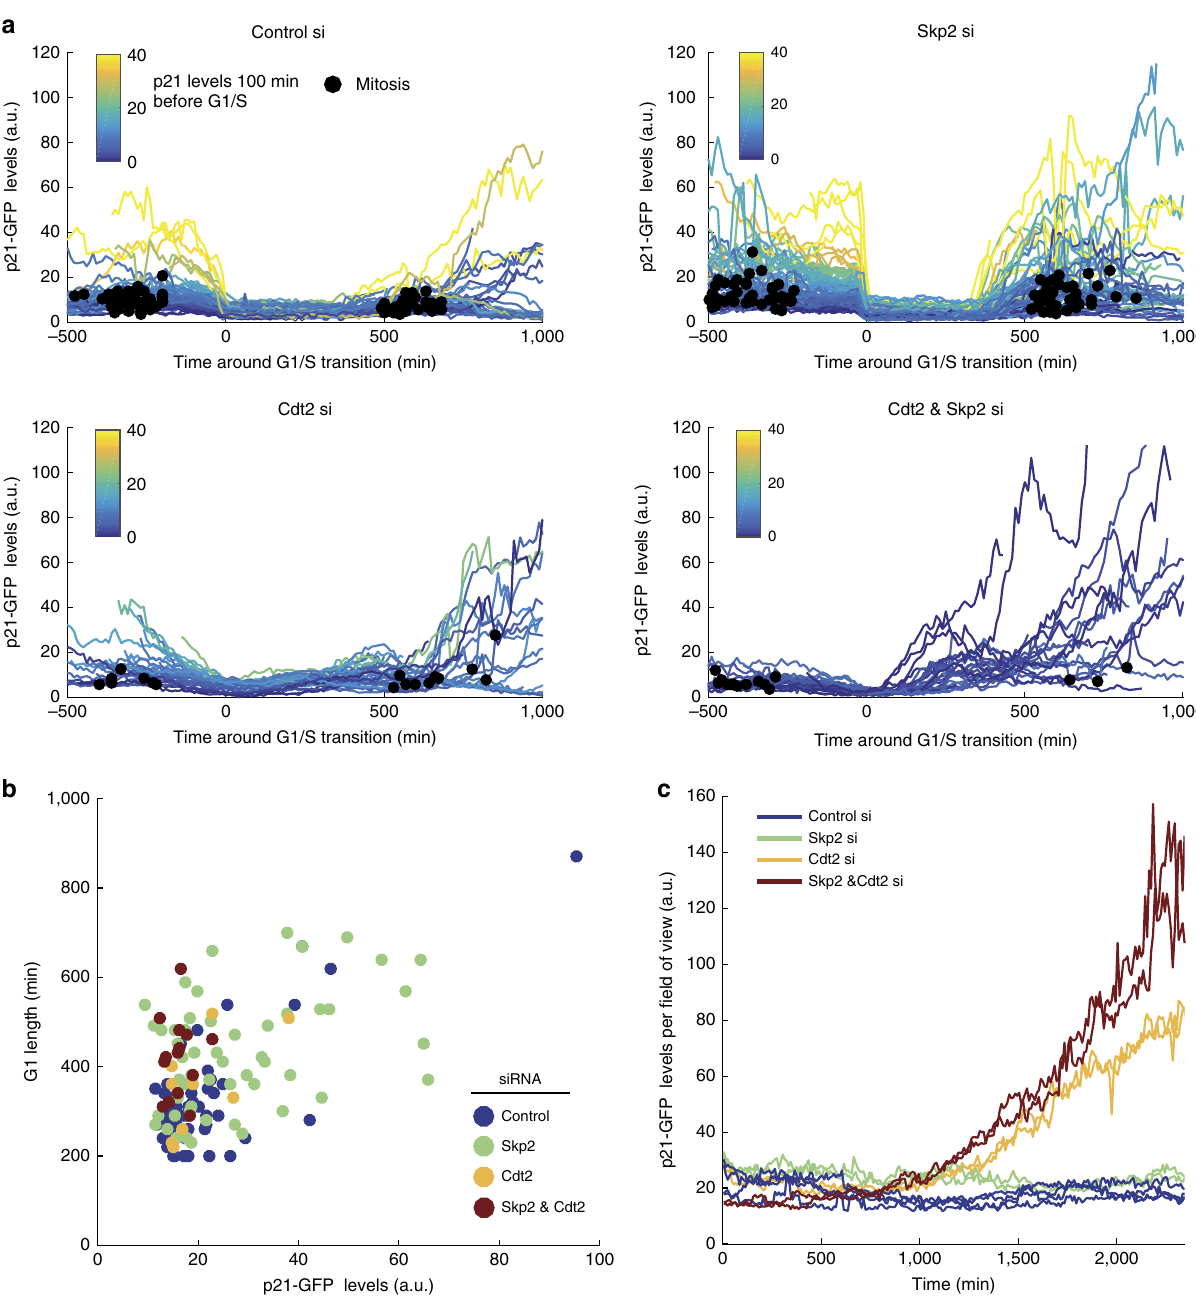
Figure 5 | Skp2- and Cdt2-dependent pathways degrade p21 with different rates and timings. ( a ) Single-cell traces, coloured by p21-GFP intensity in G1, aligned to the G1/S transition. Four siRNA treatments are shown: n ¼ 65 cells, control; n ¼ 81, Skp2; n ¼ 37, Cdt2; n ¼ 25, Skp2 and Cdt2 co-depletion. Black circles represent mitosis. Note: only cells entering S-phase are shown. ( b ) Graph shows correlation between p21-GFP intensity and G1 length for each siRNA condition shown in ( a ): n ¼ 50 cells, control; n ¼ 54, Skp2; n ¼ 9, Cdt2; n ¼ 14, Skp2 and Cdt2 co-depletion. ( c ) Graph shows average p21-GFP nuclear level across FOV for four different siRNA treatments. Four FOVs are shown for control siRNA cells and two FOVs are shown for the other treatments, each curve is one FOV. Control siRNA is shown in blue, Skp2 siRNA is shown in green, Cdt2 siRNA is shown in yellow and double Skp2 and Cdt2 depletion is shown in